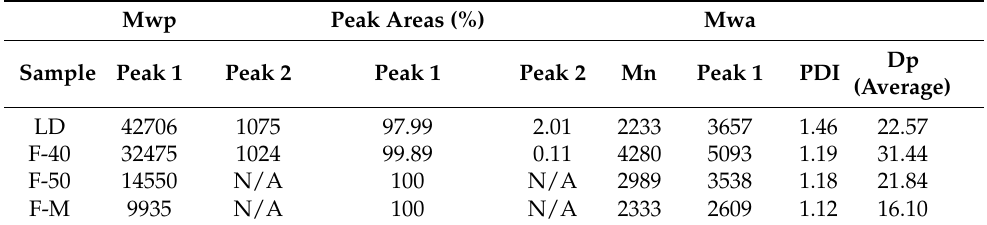
Table 1. The relative molecular weight information of linear dextrin fractions.